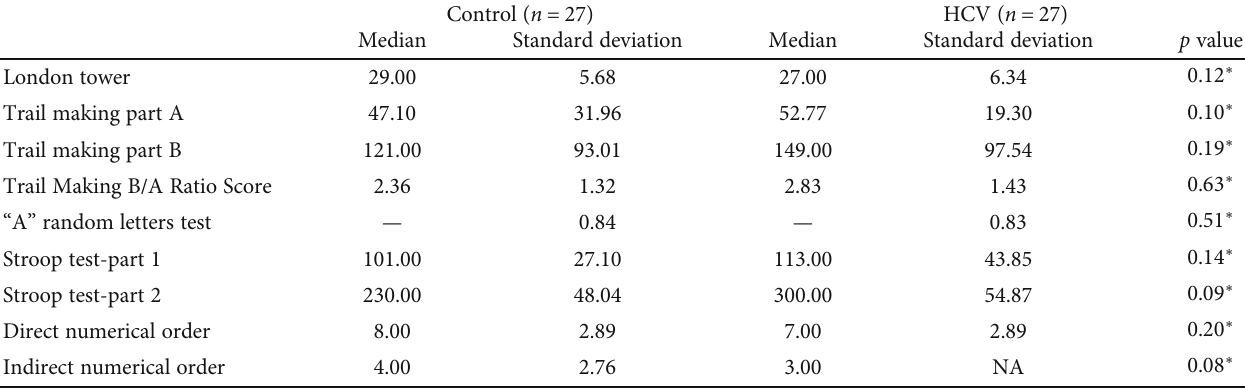
Table 6: Descriptive statistics of the Tower of London test, trail test, random letter test, Stroop test and digit test (forward and reverse order).